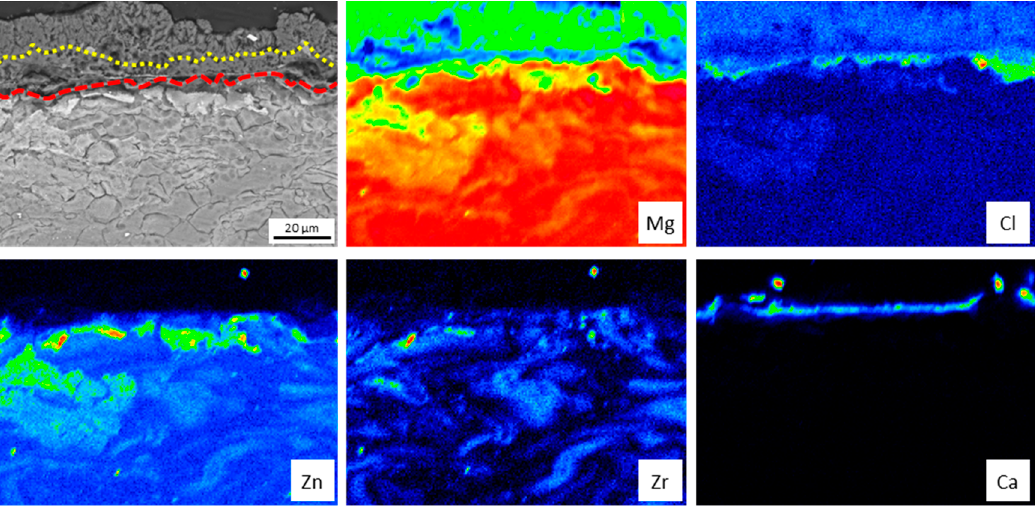
Figure 9. EPMA maping of elements distribution in the cross-section of corroded ZKX500 Mg alloy.